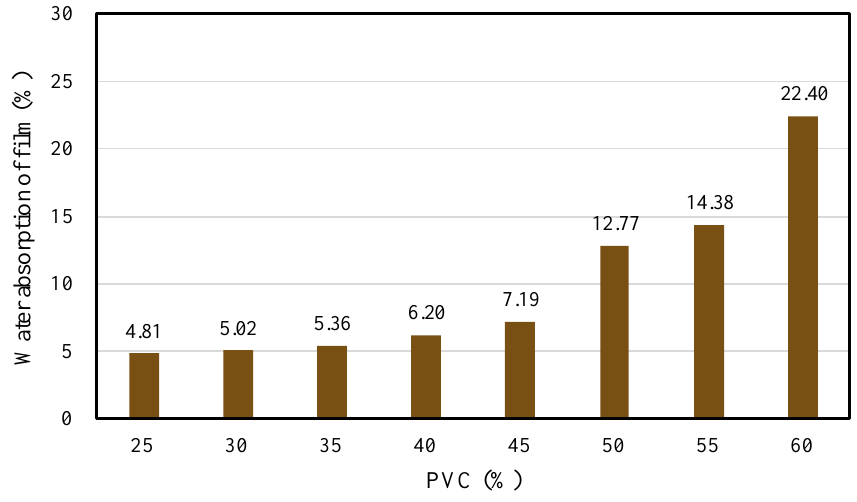
Figure 6. Effect of PVC on water absorption of paint’s film.